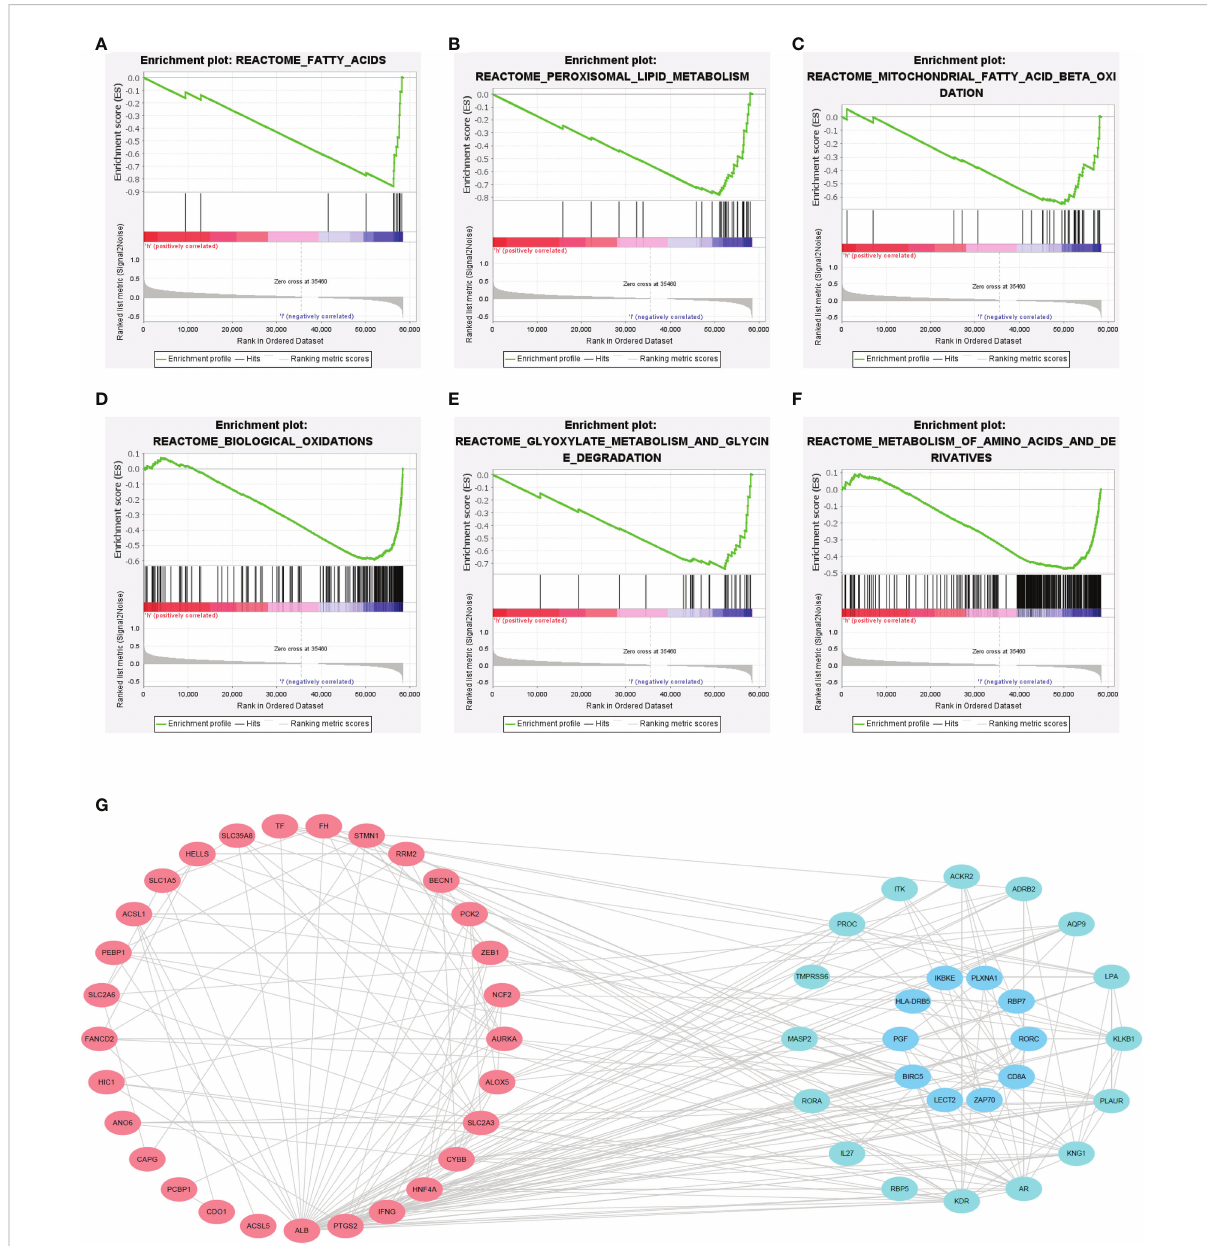
FIGURE 6 (A – F) Gene set enrichment analysis (GSEA) of the high-FIPS and low-FIPS subgroups in the TCGA cohorts. (G) A protein-protein interaction (PPI) network suggesting the relationship between ferroptosis-relate genes (FRGs) and immune-relate genes